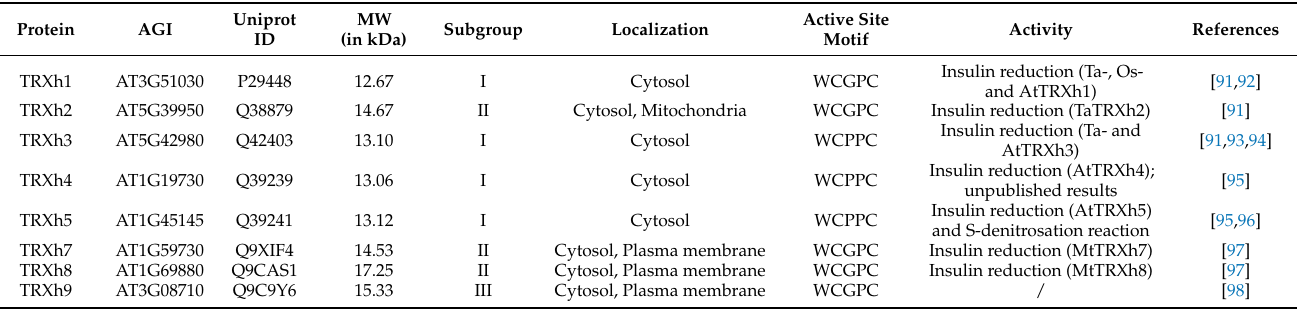
Table 2. Arabidopsis h-type